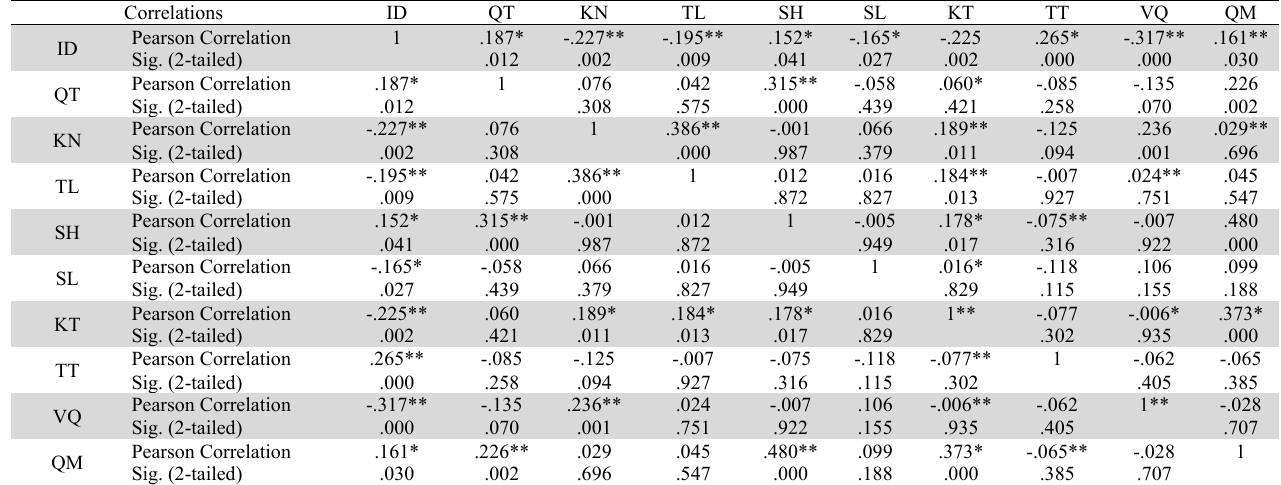
.707 (Source: Results of running SPSS 22)